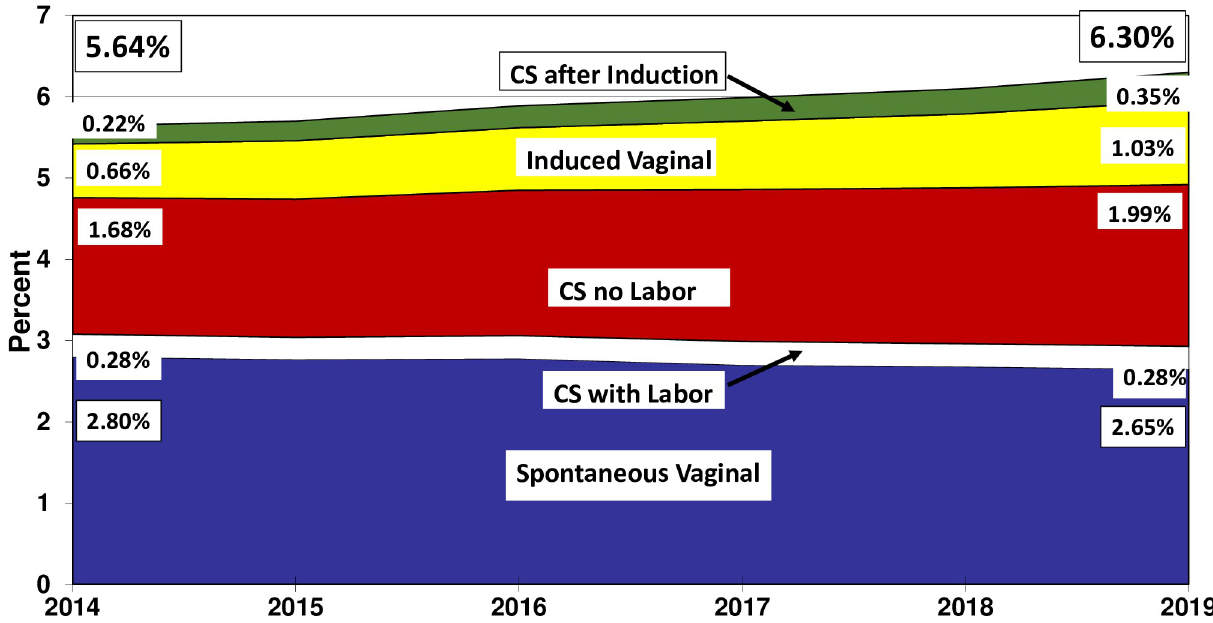
Fig 3. Percentage of singleton, late preterm births, out of total births, by method of delivery, United States, 2014–2019.